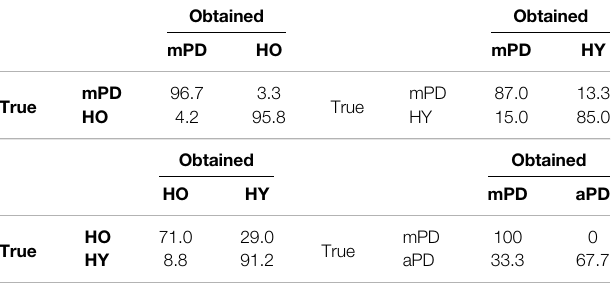
Percentages along the diagonal and off-diagonal represent the correct and incorrect predictionrates,respectively.mPD,HO,HY,andaPDrepresentmildPDpatients,healthy older individuals, healthy young individuals, and advanced PD patients,